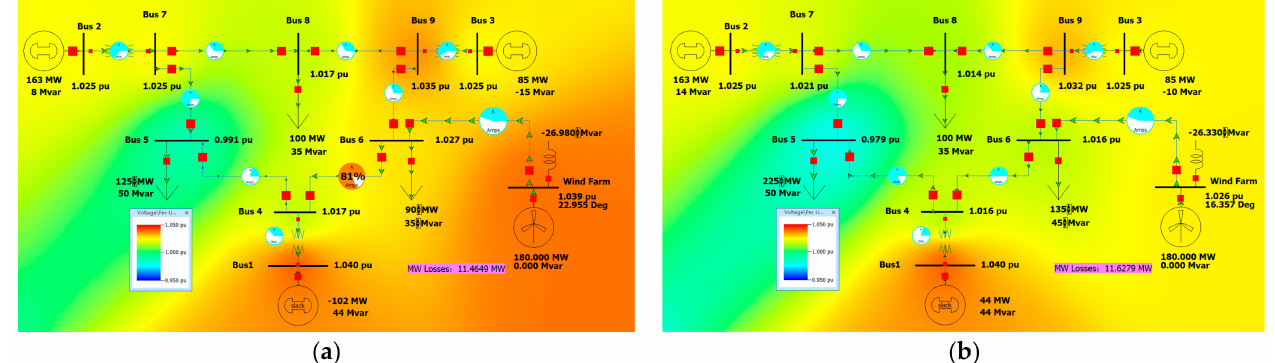
Figure 7. Simulation results when tower B is connected to bus 6 (300 km) after adding induc- tance. ( a ) The results under the minimum load condition and ( b ) the results under the maximum load condition.